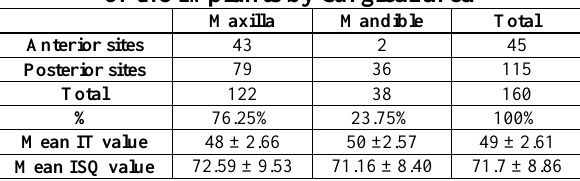
Table2: Correlation between mean ISQ and insertion torque values Primary stability